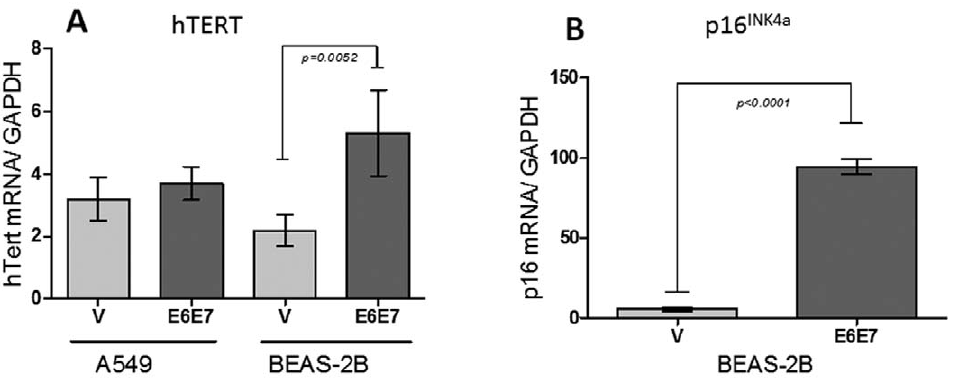
Figure 3. Telomerase (hTERT) and p16 INK4a transcripts are overexpressed in A549 and BEAS-2B cells transfected with pLXSNE6E7 constructs. A : hTERT mRNA detection is significantly increased in BEAS-2B cells transfected with HPV16 E6E7 constructs as detected using qRT-PCR (p=0.0052). B : p16 INK4a detection is significantly increased in BEAS-2B cells as detected using qRT-PCR (mean 6 SD, p , 0.0001, unpaired two-tailed Student’s t-test).